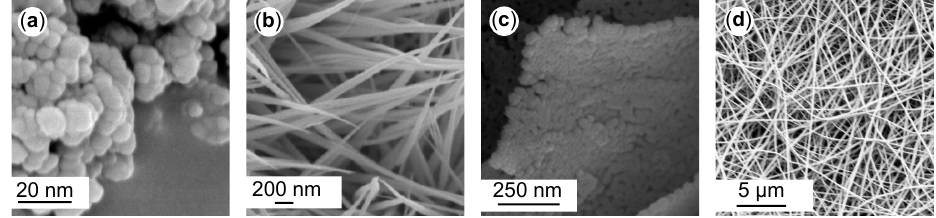
Figure 1. Different material structures. ( a ) 0D: SiO 2 nanoparticles [16]; ( b ) 1D: CoO nanowires [17]; ( c ) 2D: ZnO–NiO nanosheets [18]; and ( d ) 3D: PA6 nonwoven structure [19]. All reproduced from articles distributed under the terms and conditions of the Creative Commons Attribution (CC BY)